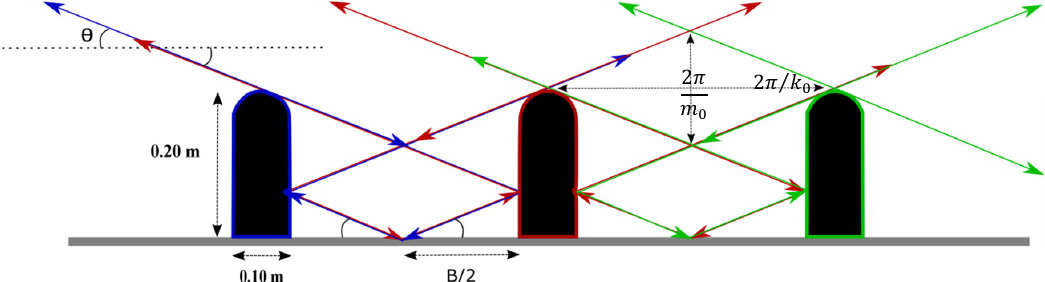
Figure 8. Sketch of the experimental arrangement in the second resonance condition ( 𝐵 = 0.20 𝑚,𝜃 = 30.7°,𝜔 = 0.42 rad/s) . The arrows represent the path of the primary beams. The downward propagating IW beams are first reflected on the neighbouring wall and then on the tank bottom, midway between two rounded ridges, and finally on the original ridge. The phase is constant along each beam, and changes by 𝜋 at each reflection on a solid surface. This leads to a constructive interference between the IW beams: the downward propagating IW beam generated by the blue ridge (blue arrow) is superimposed on the upward propagating IW beam generated by the red ridge (red arrow).